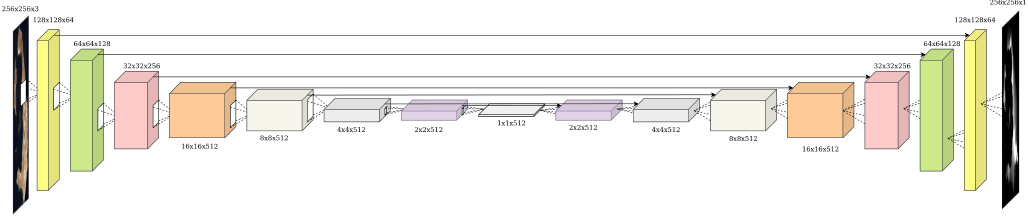
Figure 2. The generator architecture of choice: U-net [45]. It consists of an encoder that downsamples the input image using convolutional blocks up until the bottleneck layer, where the high-level semantic features of the input reside (for an explicit demonstration, see [53]). Thereafter, deconvolutional blocks upsample the image to the desired dimensions. The skip connections, denoted by pointed arrows between corresponding layers of the encoder and the decoder, facilitate training by providing crucial lower-level information from the encoder to the decoder. Given that the input and the output have the same low-level structure, these low-level features serve as the canvas that guides the decoder in the generation of the final